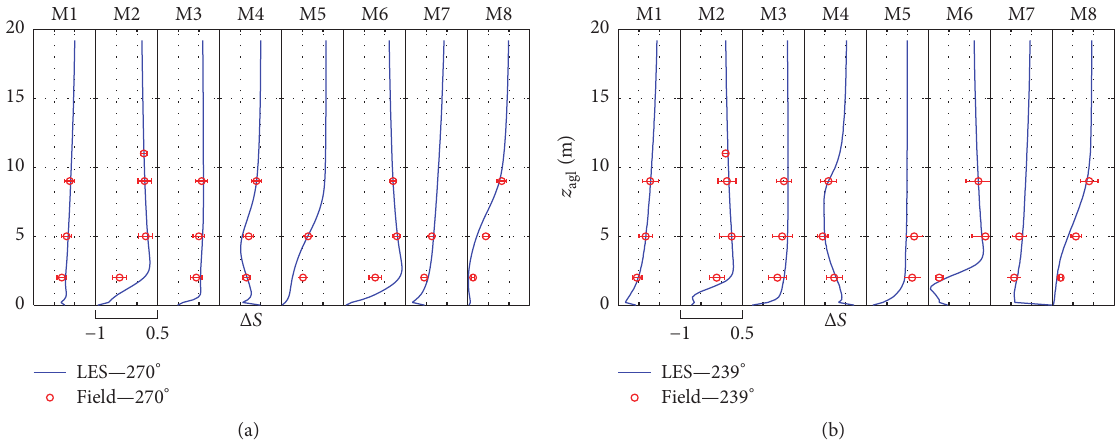
Figure 9: Vertical profiles of the velocity speedup ( Δ𝑆 ) at different masts (M1–M8) in the case of 270 ∘ (a) and 239 ∘ (b) wind directions.